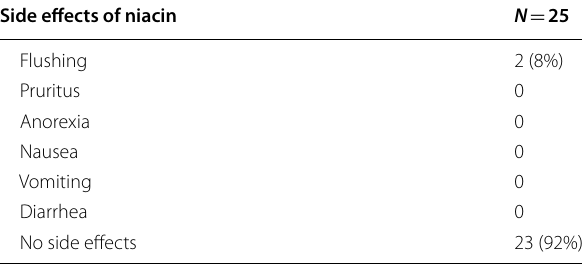
Table 6 Side effects of